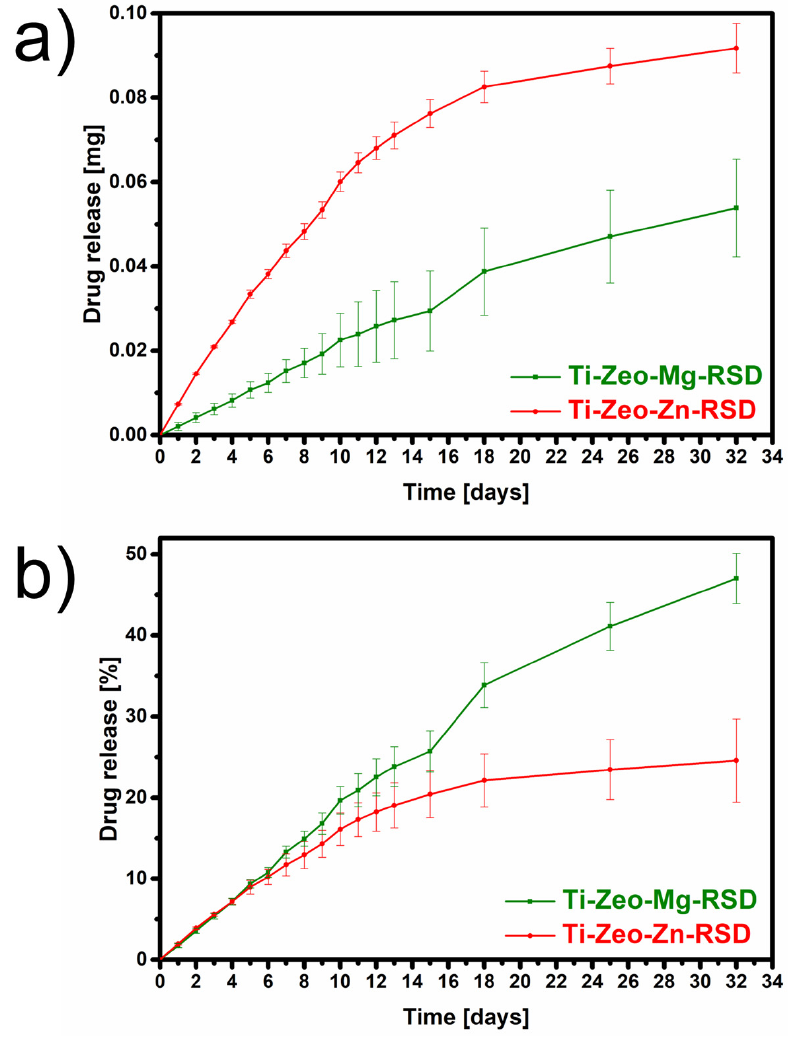
Figure 7. The amount of the drug released from the prepared materials. The cumulative amount of drug released from the material in milligrams ( a ) and in % ( b ) (three repetitions were performed for each ma- terial).